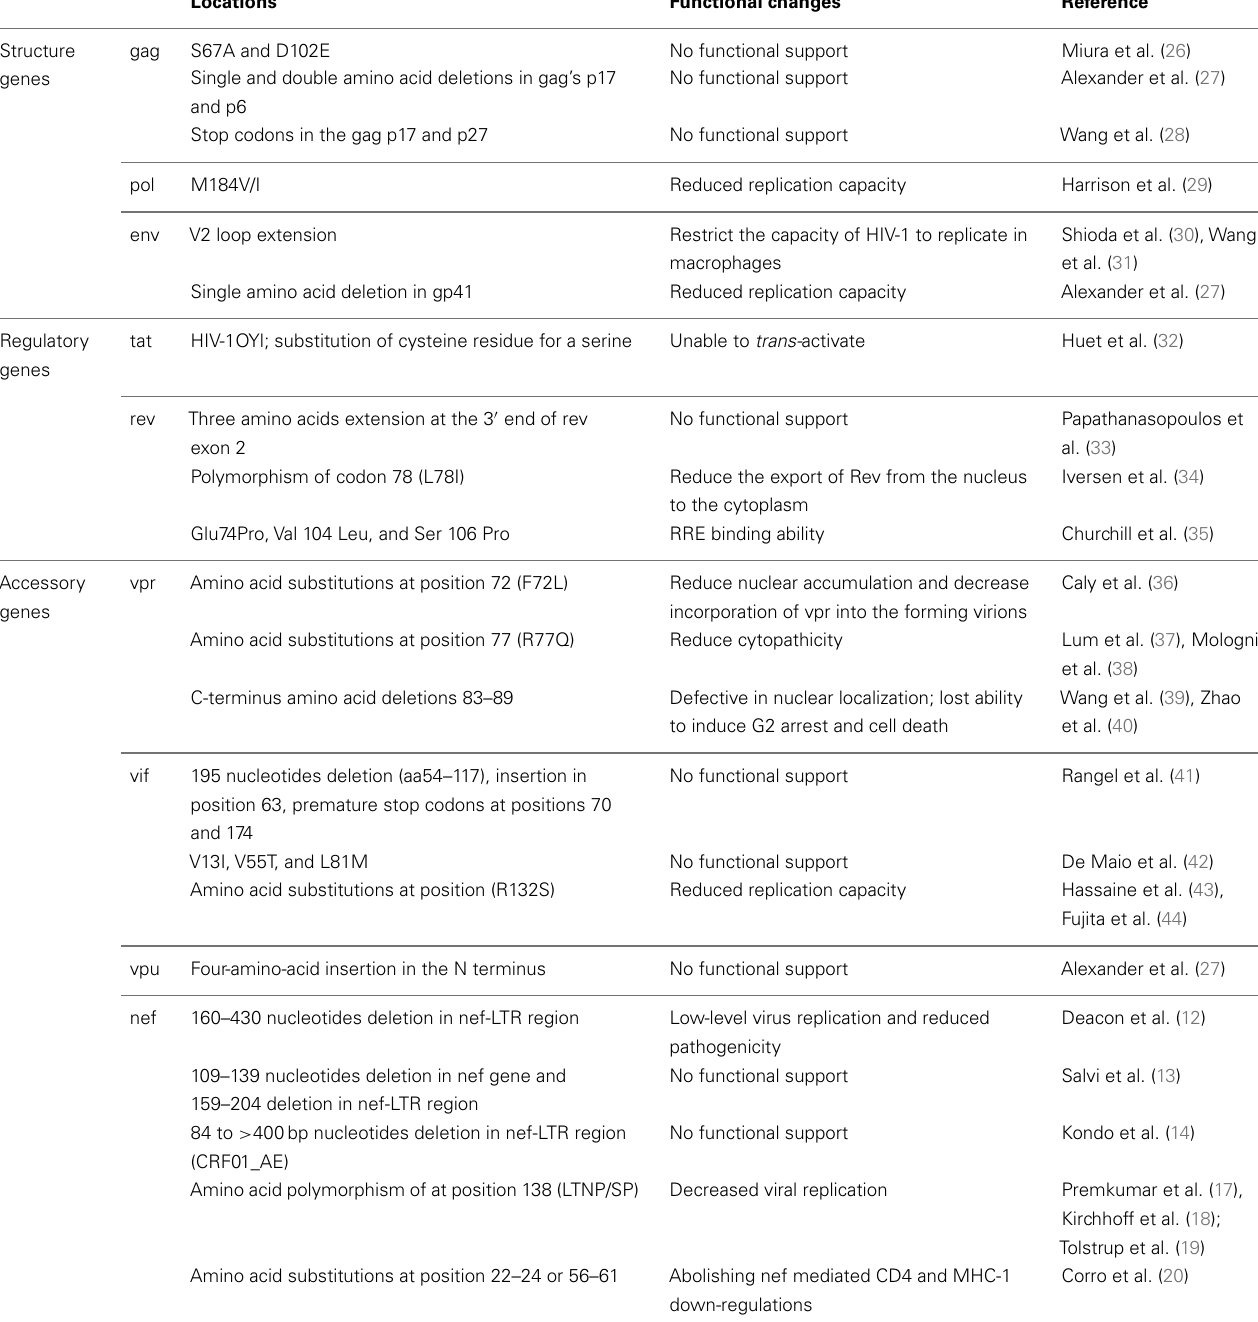
Table 1 | Summary of HIV-1 genetic mutations that associated with non-progressive HIV disease.